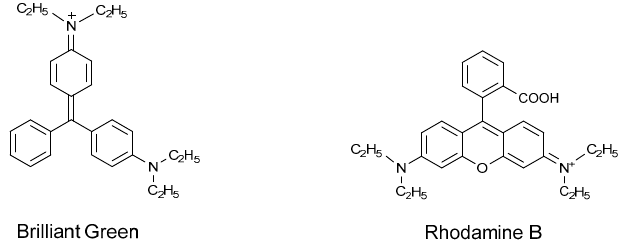
Figure 9. Brilliant Green (a triphenylmethane) and Rhodamine B (a tricyclic immonium/oxonium cation) structures.